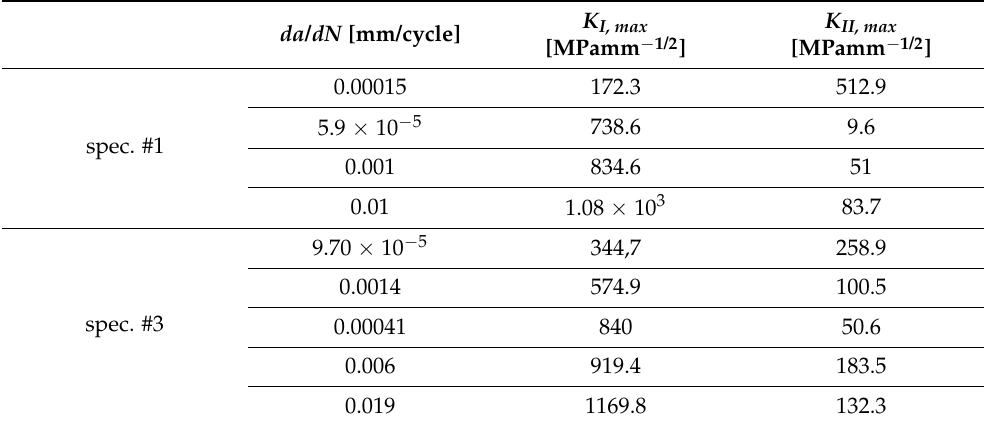
Table 1. Tests at R = 0.1, maximum values of K I and K II per cycle, and FCG rate [5].